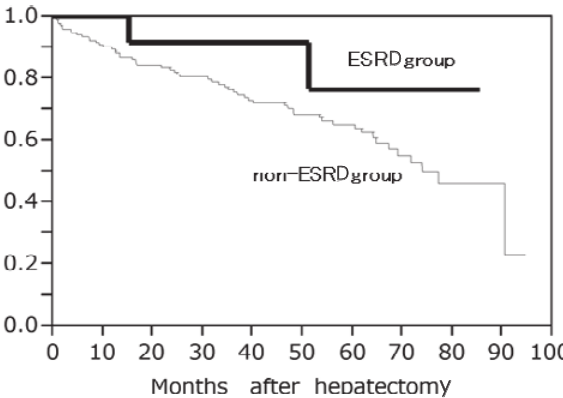
HCC, hepatocell u lar carcinoma; ESRD g ro u p, patients w ith end- sta g e renal disease; non-ESRD g ro u p, patients w itho u t end-sta g e renal